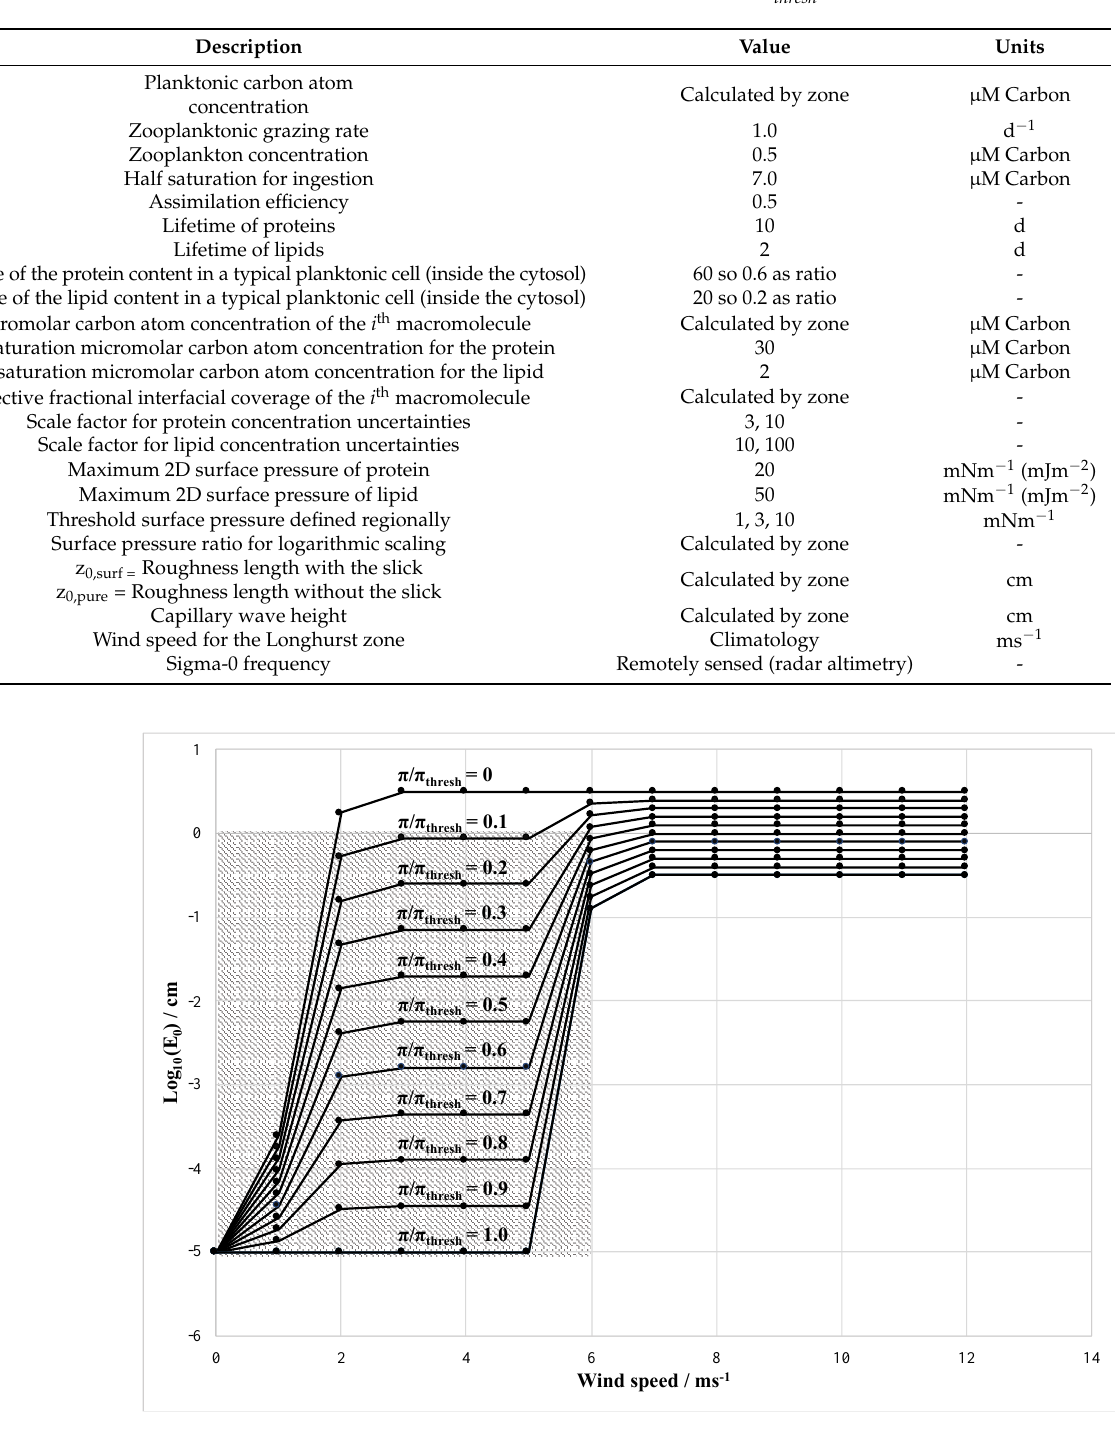
Table 1. Model parameter descriptions and values. The use of alternate values for a prot and a lip is discussed in Section 2.7 and the choice of alternative values for π thresh is discussed in Section 2.8.